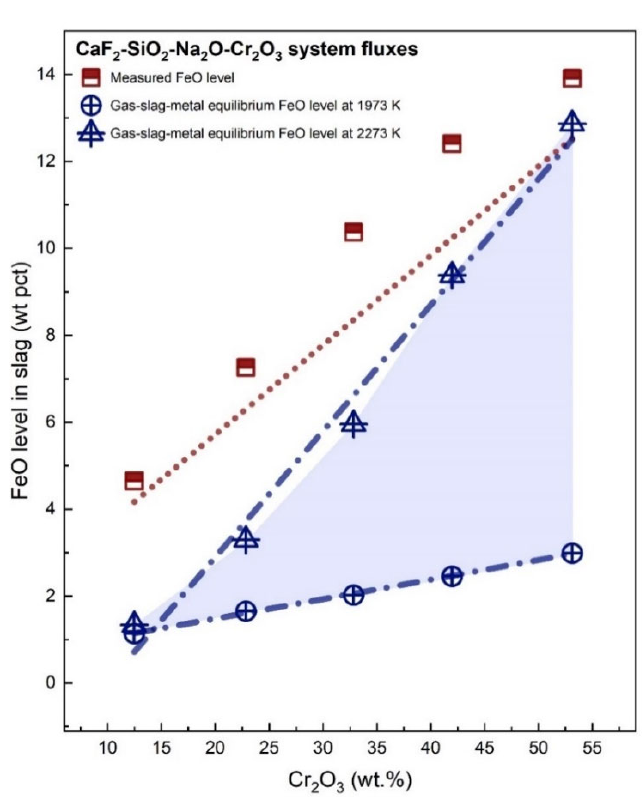
Figure 3. FeO level in the slag as a function of the Cr 2 O 3 addition level in the